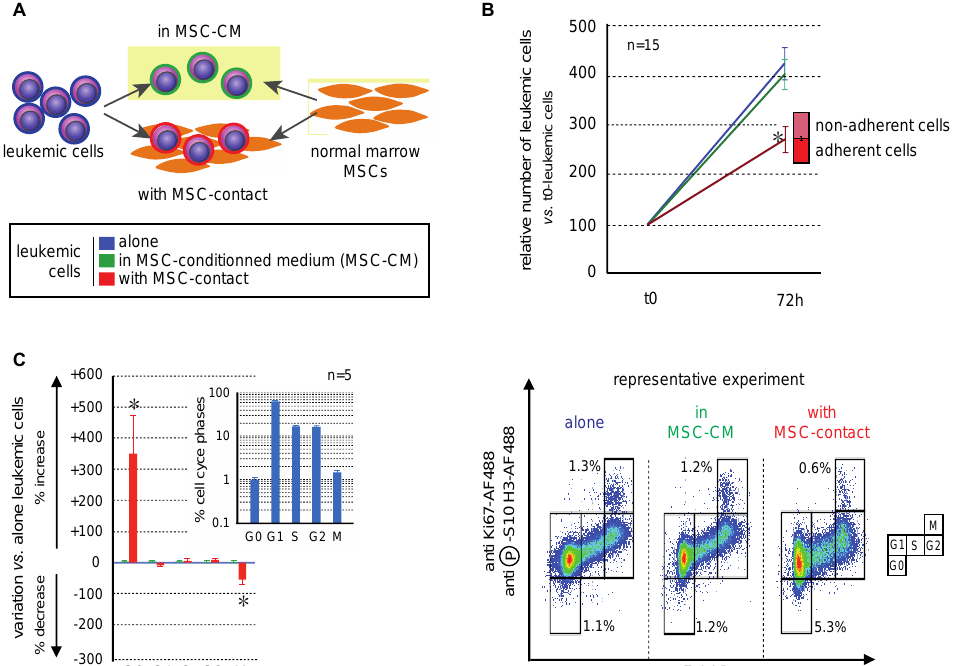
Figure 1. Mesenchymal stromal cells (MSCs) decreased leukemic cell proliferation. Experiments were performed with KG1a leukemic cells cultured alone (blue), with MSC-CM (green), or in coculture with MSCs (red). ( A ) Experimental design of mono- and coculture of MSCs and leukemic KG1a cells. Leukemic cells were cultured in medium alone, with MSC-CM or over MSCs; MSCs were cultured alone or with KG1a leukemic cells. ( B ) Leukemic cell growth was evaluated after 72 h of mono-, MSC-CM, or coculture (nonadherent cells represent cells that do not adhere to MSCs after 72 h of coculture, n = 15). ( C ) Cell cycle was analyzed by a flow cytometry multilabeling protocol using anti-Ki67-AF488, anti-phosphoS10-H3-AF488 and 7AAD ( n = 5). Variations in MSC-CM and cocultured vs. monocultured KG1a in cell cycle phases after 72h are shown on the left and a representative experiment is presented on the right. * p <